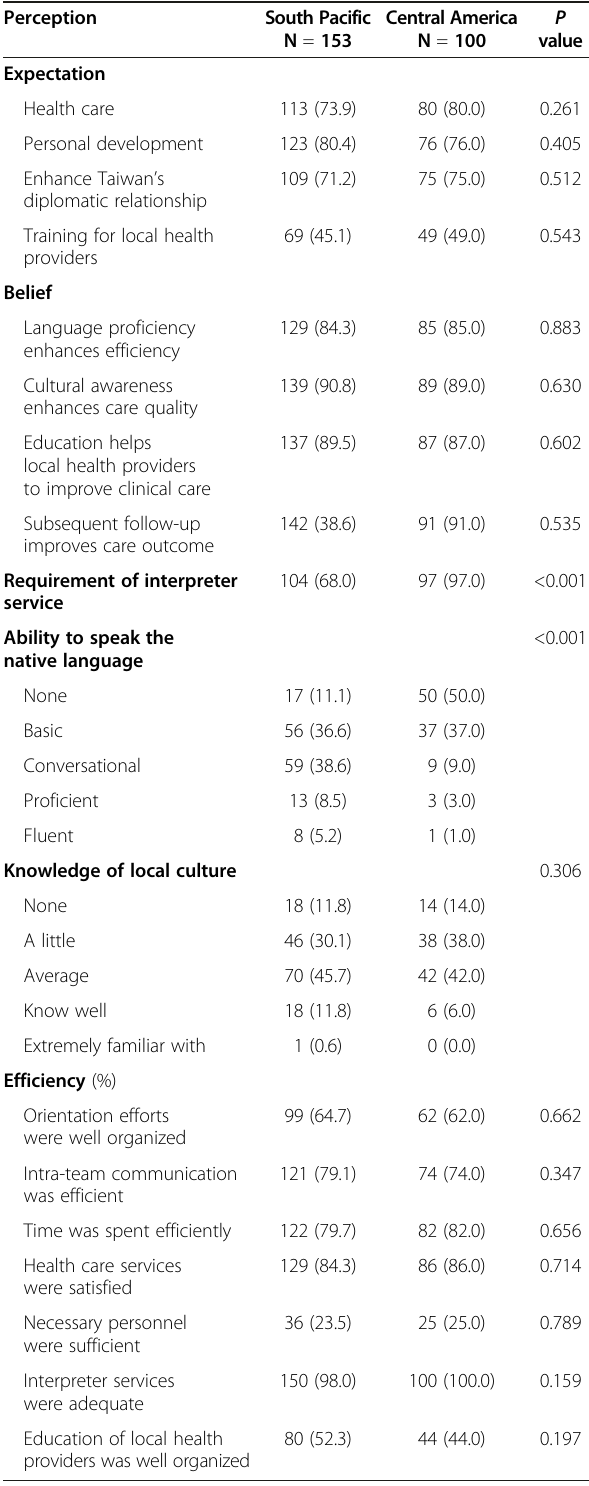
Table 6 Perceptions of 253 health professionals